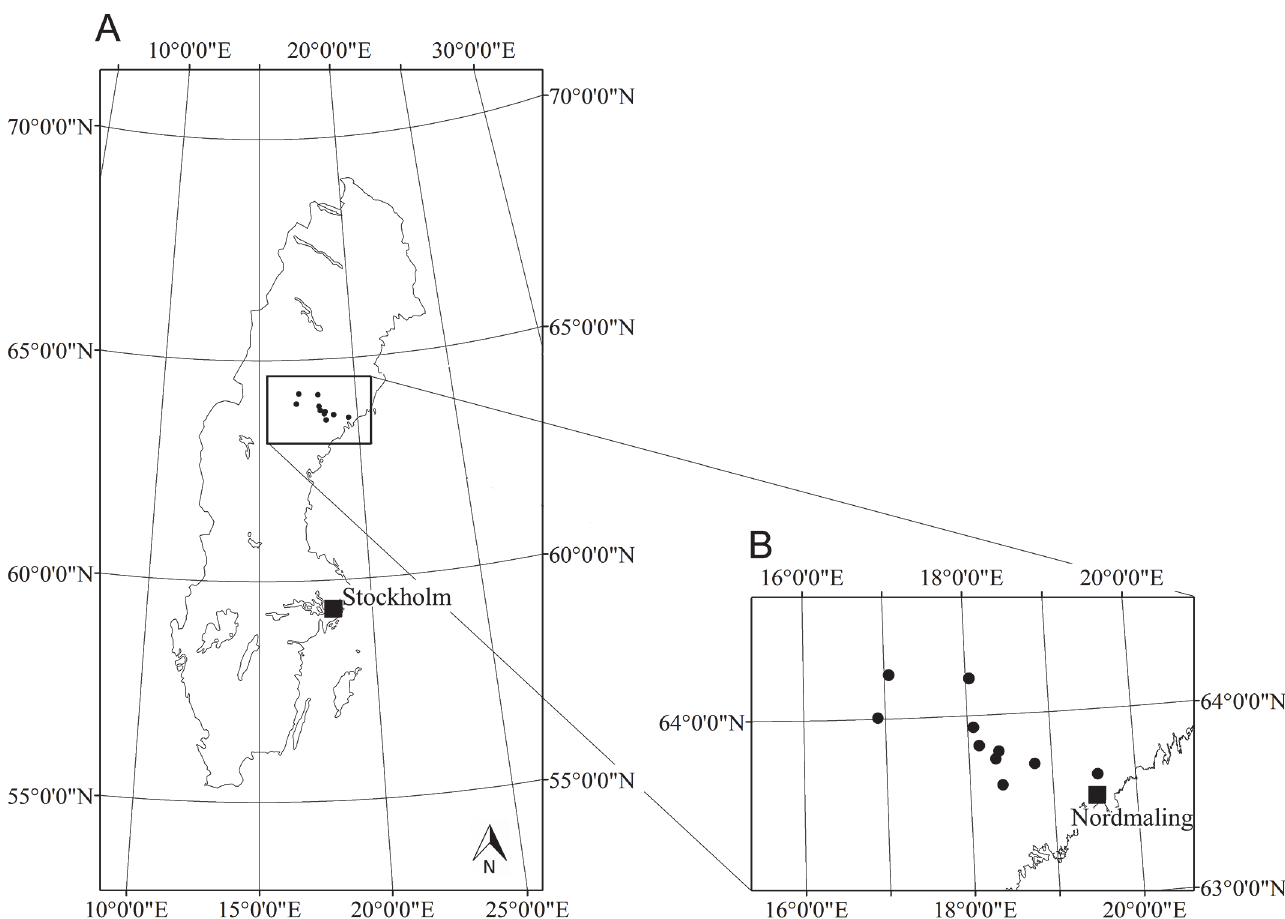
Fig 1. Study area. The location of the 10 clear-cuts in Sweden (A) and in the region (B). The distance between the vertical grid lines in B is approximately 50